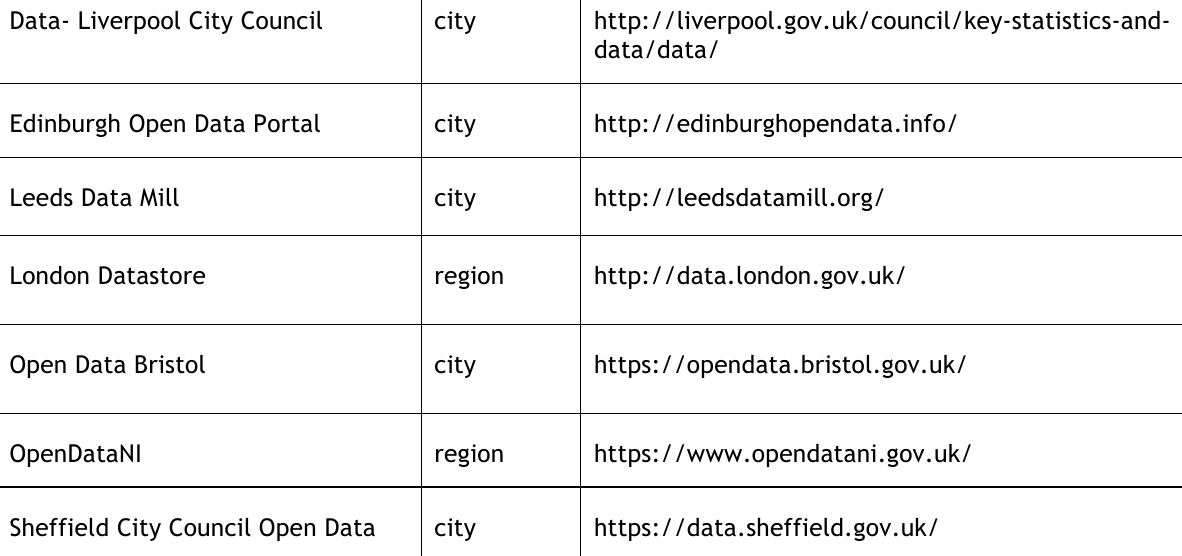
Spanish open data catalogs. The word frequency count for Spanish open data catalogs yields 65 distinct categories. Contrary to the German case, none of the categories shown appear in all catalogs.